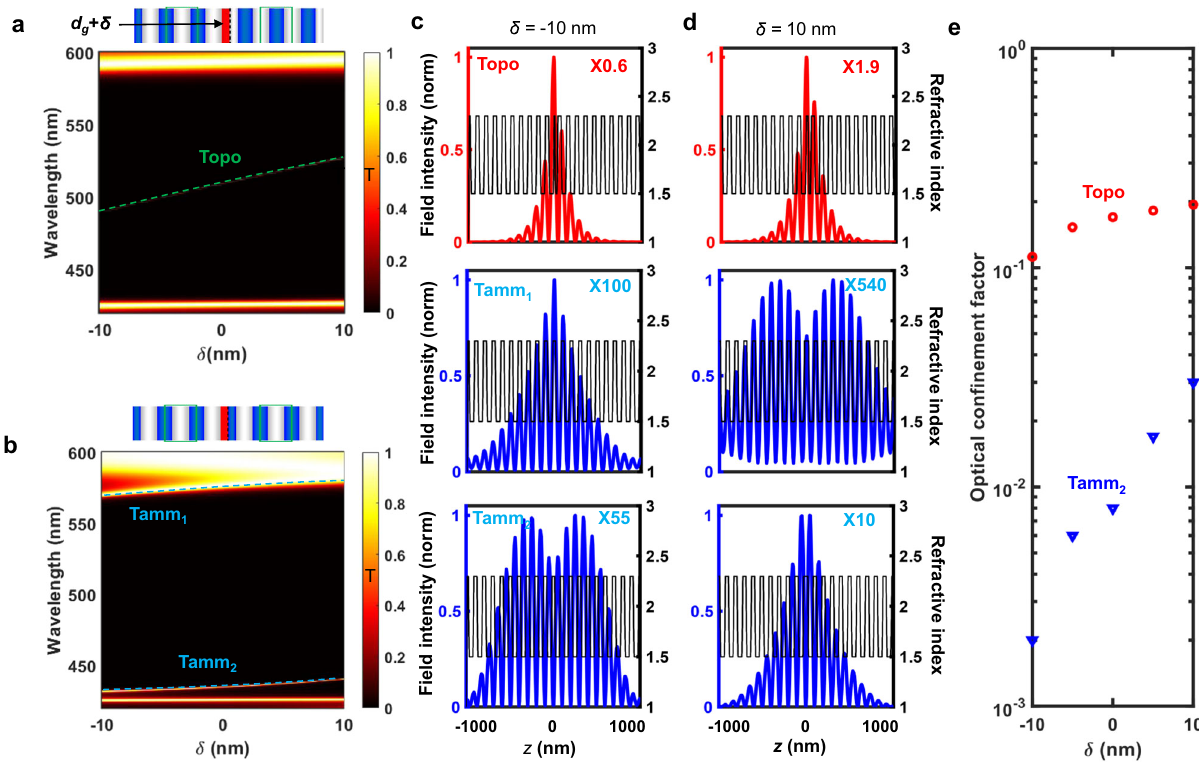
Fig. 2 | Robustness of the 1D topological microcavity. Calculated transmission spectraof a theproposedtopologicalcavity and b atrivialcavity uponvariationof the fi rst HI layer thickness by (cid:1) 10 nm ≤ δ ≤ 10 nm . Electric fi eld distributions of the